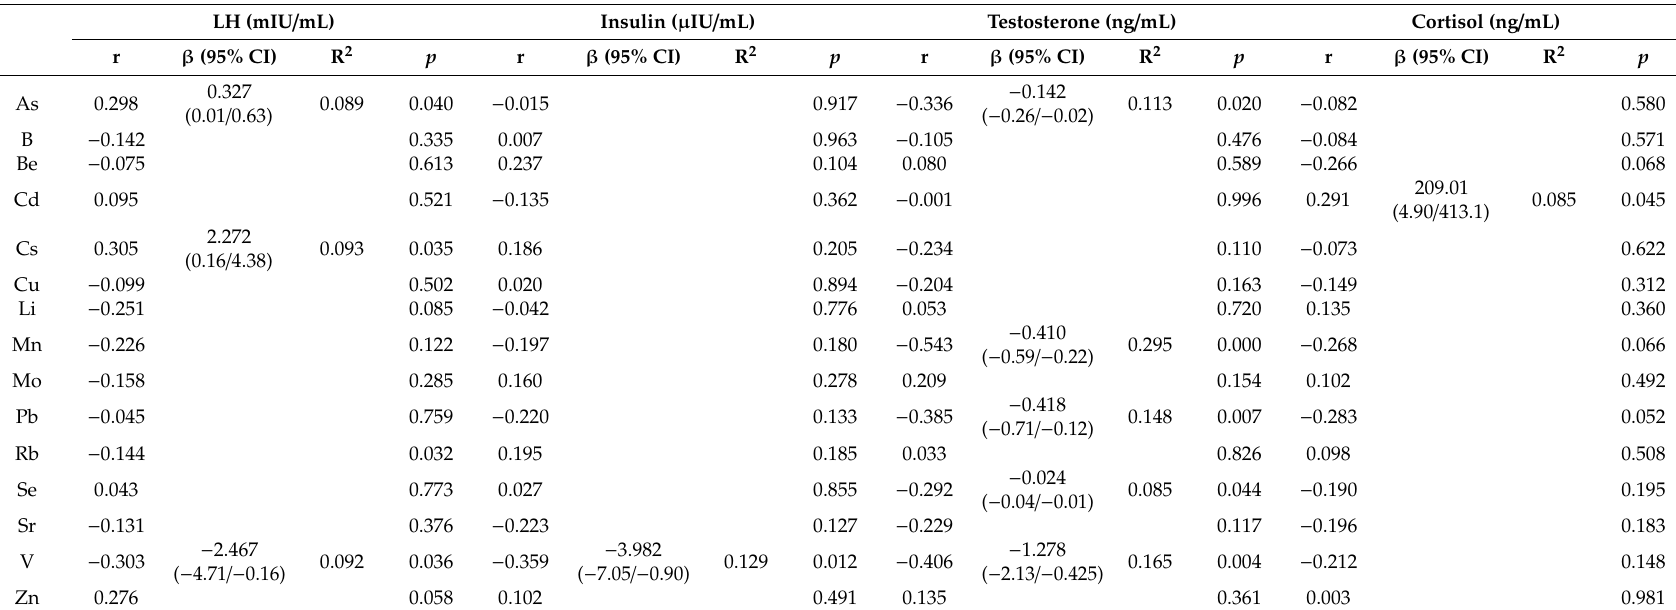
Table 5. Correlations and simple linear regressions between trace minerals and